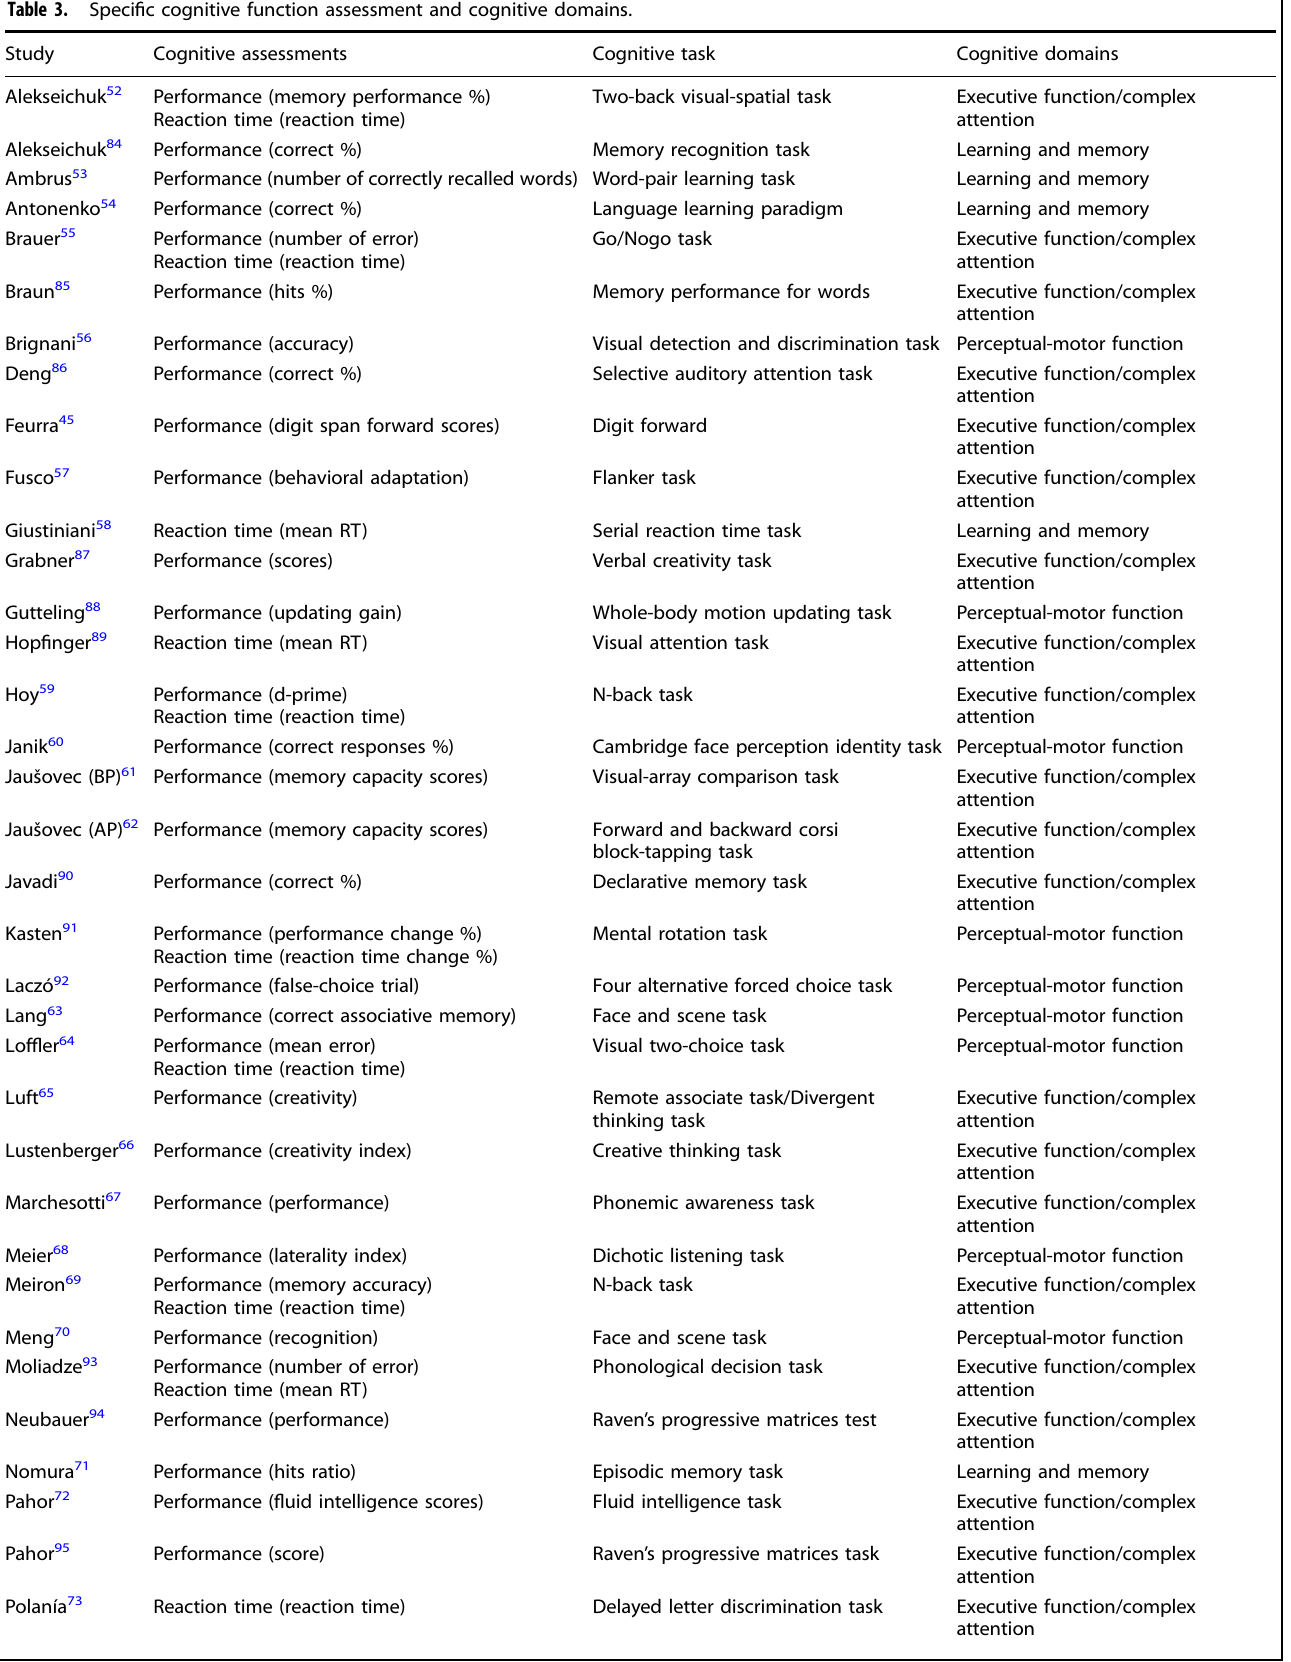
Table 3. Speci fi c cognitive function assessment and cognitive domains.